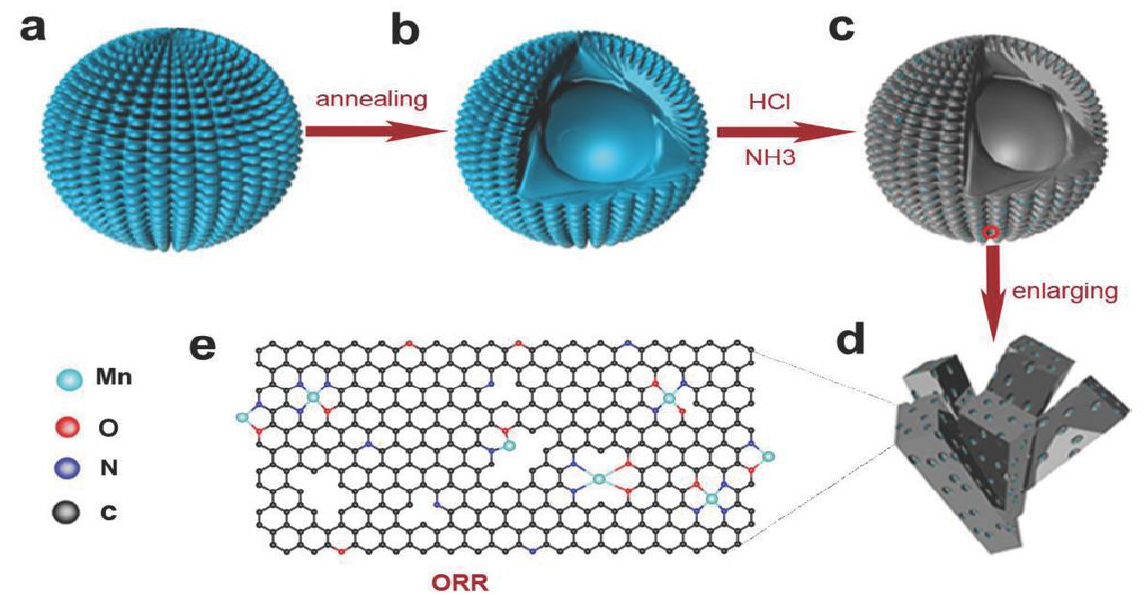
Figure 7. The synthesis process of the catalyst is shown schematically. ( a ) Precursor of Mn-BTC with a sphere-like morphology. ( b ) Ultrafine MnO nanocrystals embedded homogeneously in porous carbon framework with hollow sphere framework (MnO/C) are obtained after annealing process under N 2 . ( c ) Mn/C-NO are obtained after HCl acid etching process and NH 3 activation treatments. ( d ) Enlarged edge area illustrating the hollow sphere carbon framework is composed of porous nanorods. ( e ) Detailed structure of Mn/C-NO where Mn residues embedded in 3D graphene framework predominantly existing as single atoms coordinated with O and N atoms. (Reprinted with permission from [77]. Copyright 2018, John Wiley and Sons).